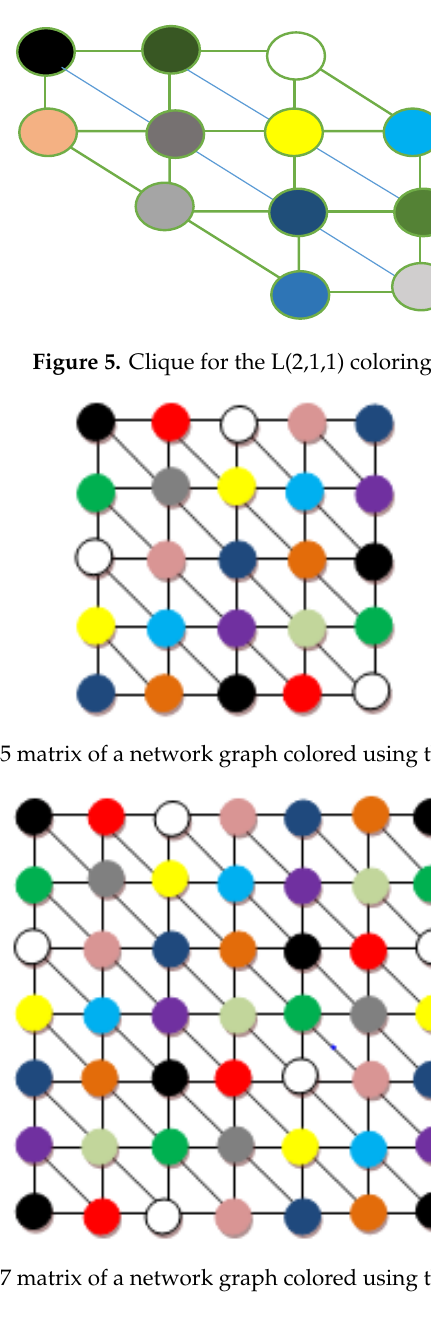
Figure 7. A 7 × 7 matrix of a network graph colored using the L(2,1,1) coloring.